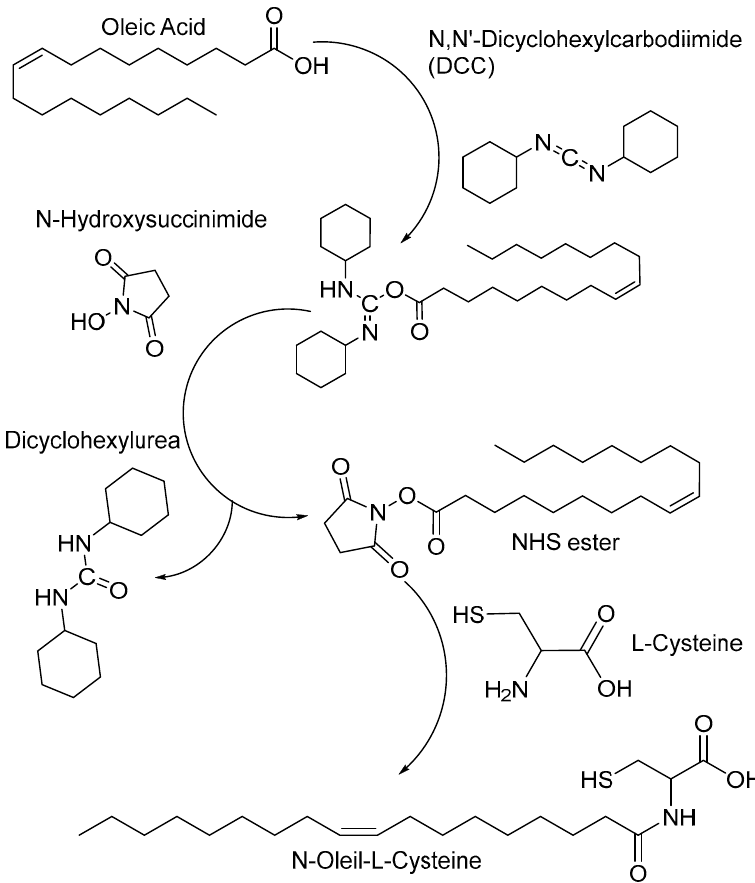
Figure 1. General scheme of the carbodiimide-based conjugation reaction for the synthesis of amphiphilic molecules of N-oleyl-L-cysteine.